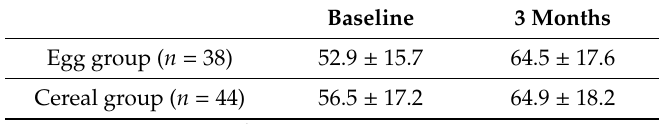
Table 4. Vitamin D concentrations in participants in the study at 3 months (nmol / L) 1